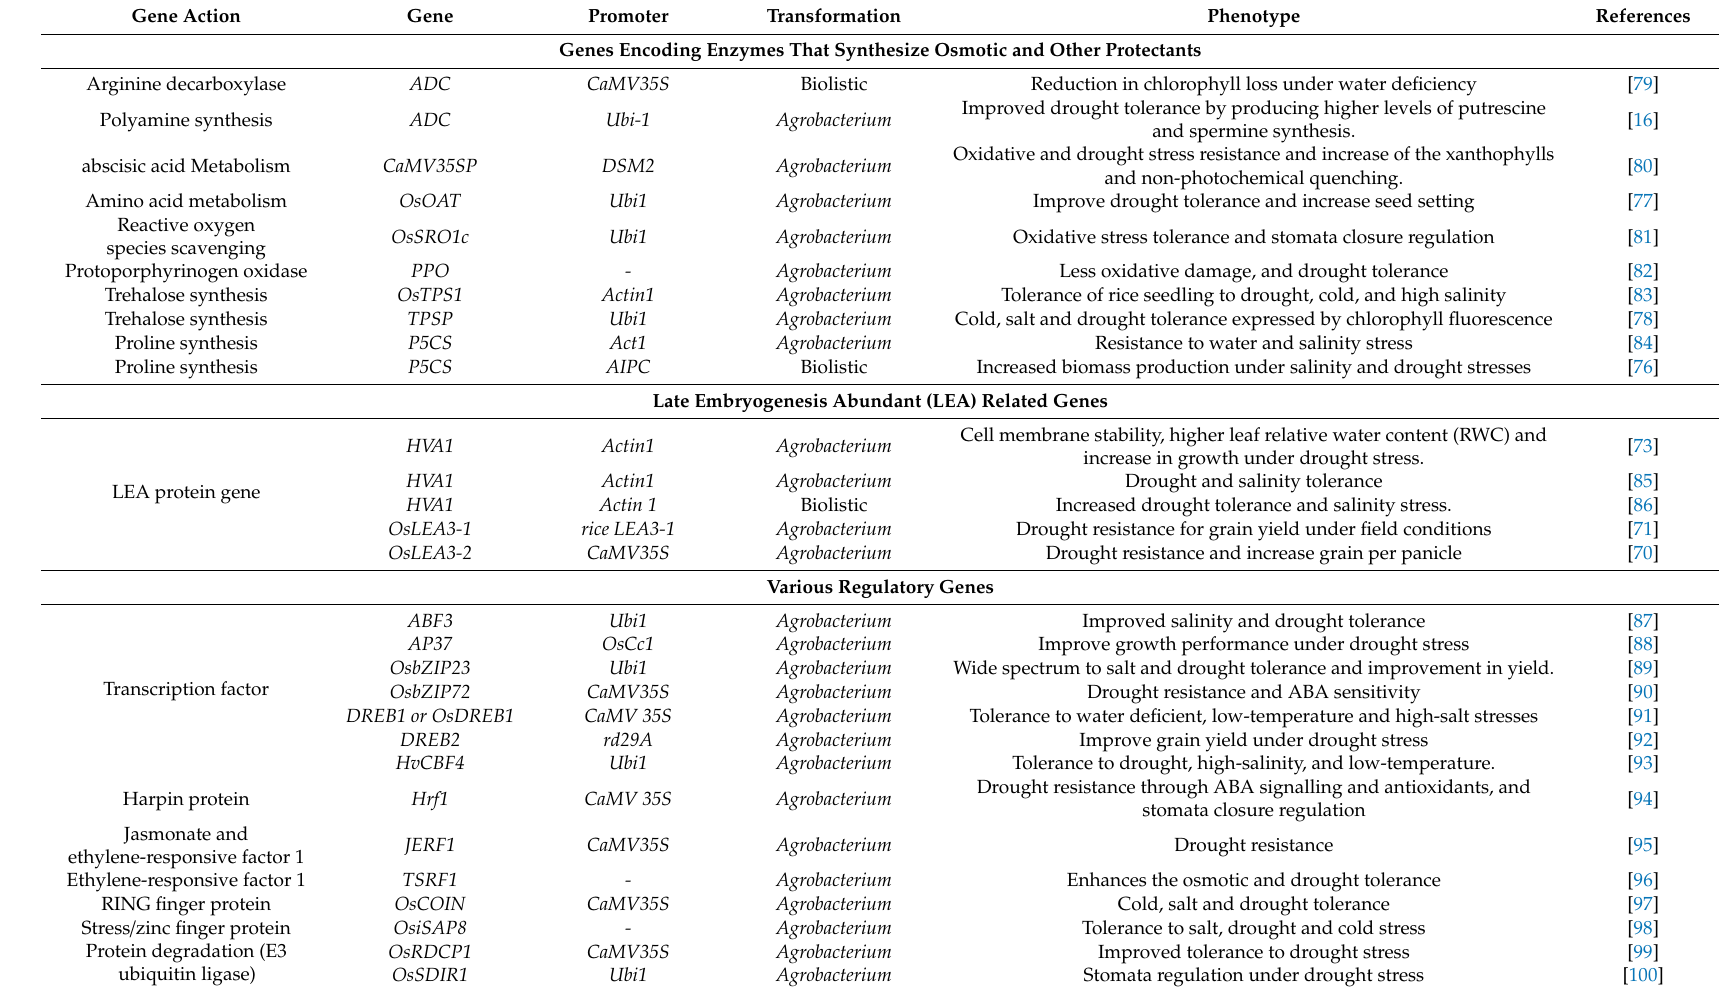
Table 2. Drought tolerant gene that has been tested in